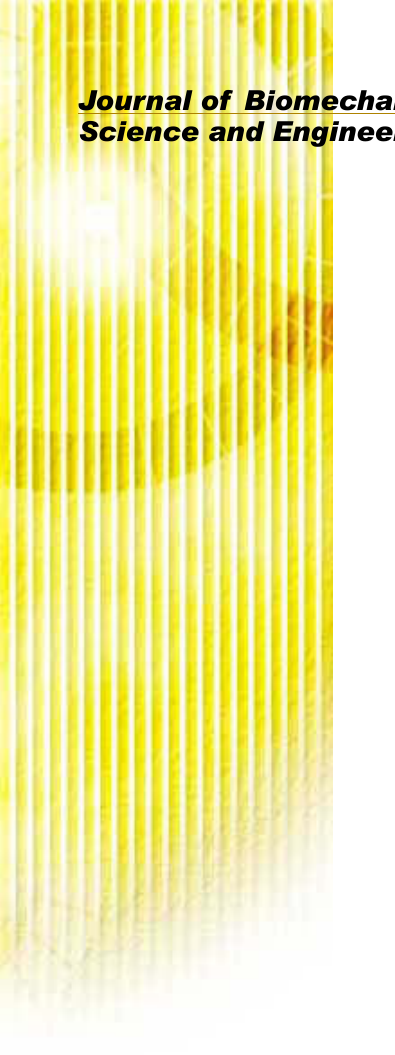
Fig. 1 Changes in mass (a) and volume (b) of the specimen in both dry and wet conditions with the demineralized duration.